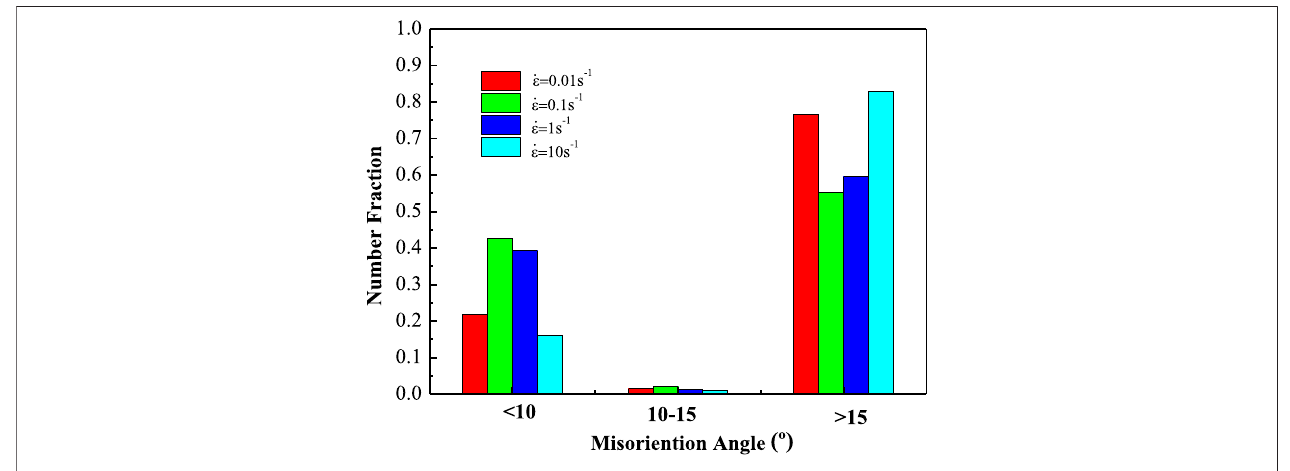
FIGURE 8 | Change of relative fraction at different misorientation angle scopes at different strain rates with the temperature of 1,100 ° C.